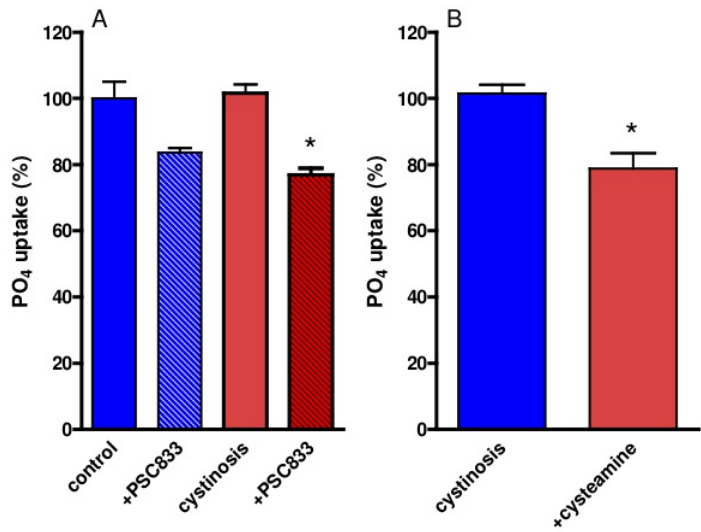
Figure 5. Phosphate uptake in cystinotic and control ciPTEC. (A) Uptake of 0.2 mM 32 P-labeled phosphate during 5 min in cystinotic (red bars) and control (blue bars) ciPTEC was determined in triplicate with or without preincubation with 5 μ M PSC883 or vehicle (0.1% DMSO) for 2 h. (B) Cystinotic cells were preincubated with 1 mM cysteamine (red bar) or vehicle (blue bar) (normal culture medium) for 1 h. Results are presented as %